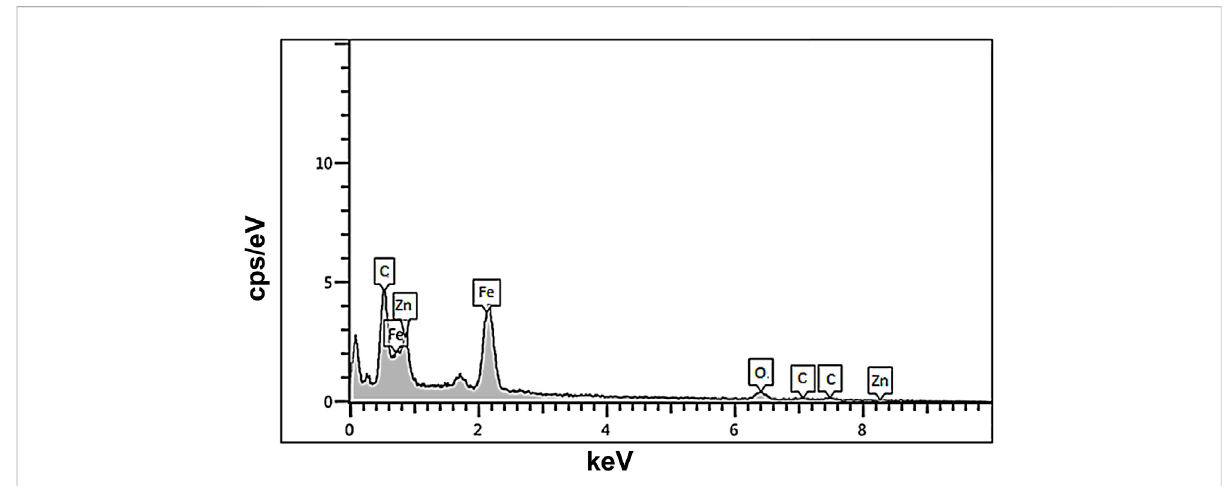
FIGURE 2 EDX spectrum of Fe 3 O 4 /Zn-metal organic framework magnetic nanostructures.